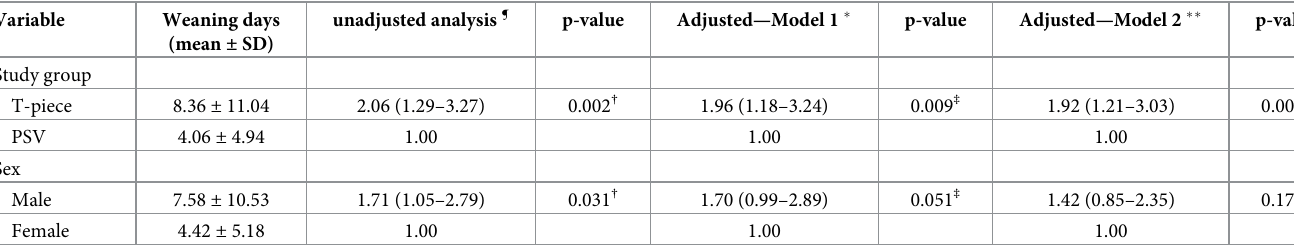
Table 5. Gamma log link models for time to liberation outcome.